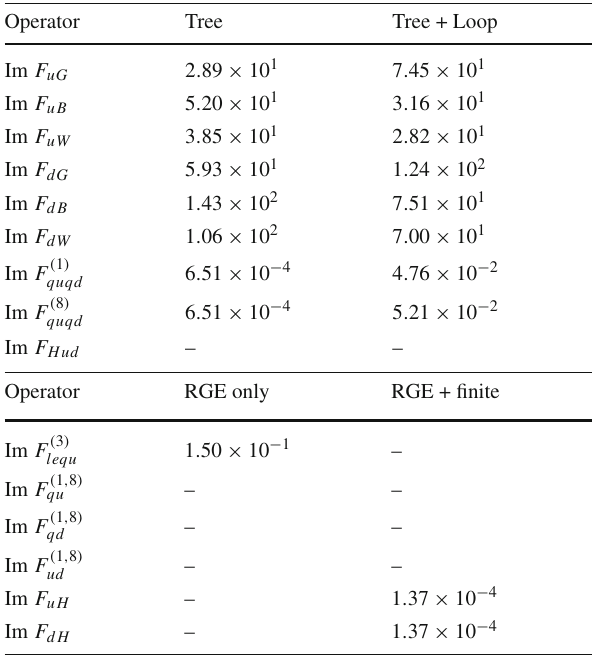
Table 13 Lower bounds on the UV scale (cid:2) in TeV, assuming F i = 1 for all the coefficients of the operators, under a U ( 3 ) 5 flavor symmetry, ) keeping terms up to O ( y 2 u , d , e